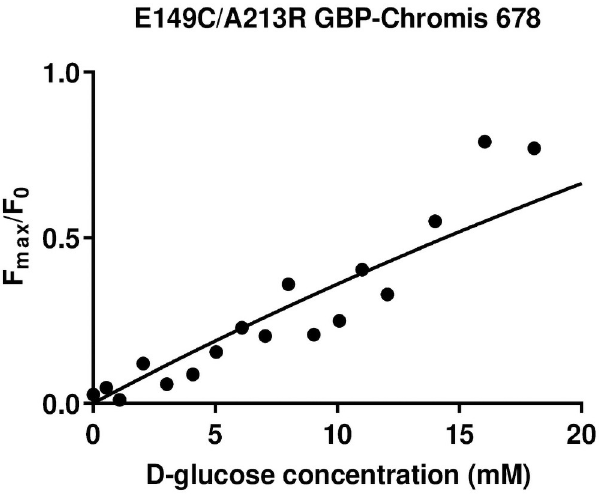
Fig 3. Fmax/F0 D-glucose concentration response curve for the dual mutant E149C/A213R GBP labelled with Chromis 678. The curve was fitted using the one site-specific binding with Hill slope formulae in GraphPad prism.